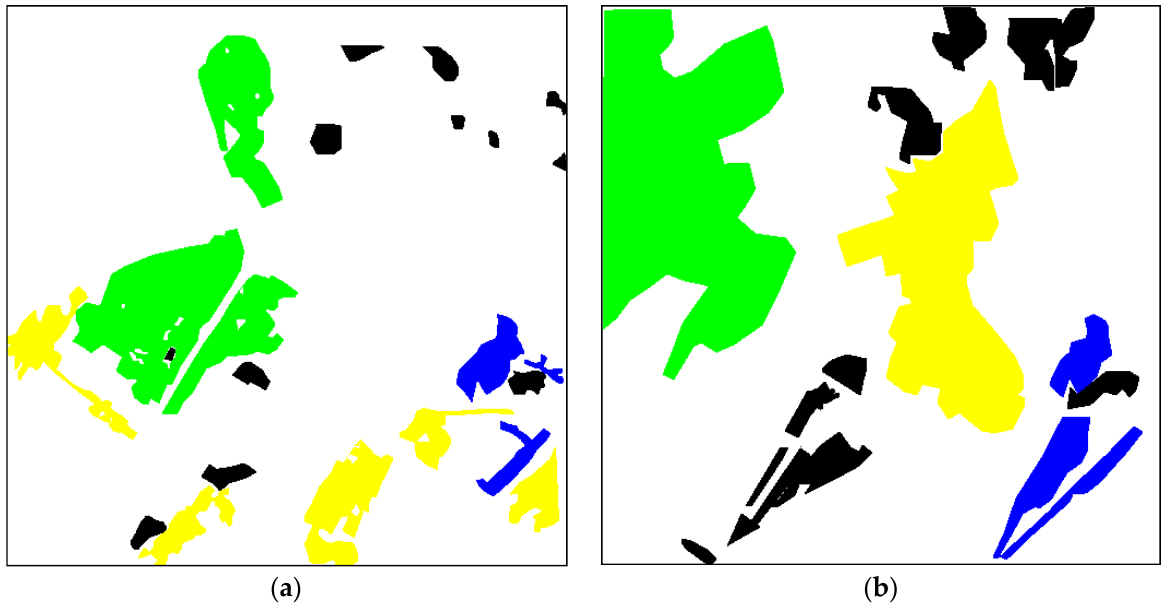
Figure 15. Three-channel fragments used for classifier training ( a ) and ground truth map ( b ) for the test image in Figure 12b.